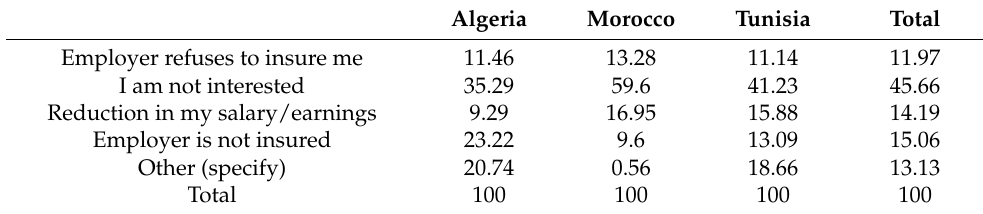
Table 1. Reasons for not being insured (%). Source: Sahwa dataset using